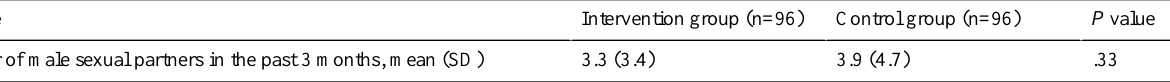
Table 2. Effect of the eHealth intervention based on the HIV risk prediction tool for men who have sex with men on HIV-related high-risk behaviors and intentions to undergo HIV testing (N=168).